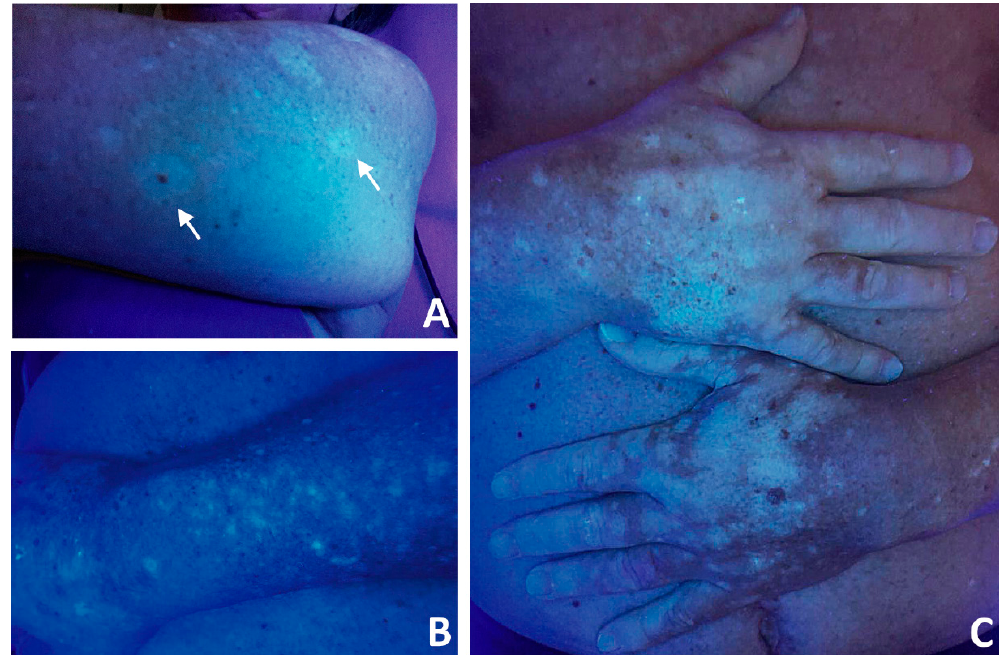
Figure 2. Leukoderma occurring in melanoma patients after treatment with check-point inhibitors. Patients with metastatic melanoma that were treated with check-point inhibitors were enrolled in the study that was approved by the IDI-IRCCS Ethical Committee (510 / 3, 2018). Photographs have been taken through Wood’s lamp examination. Either halo phenomenon around nevi (arrows, ( A )) or broad skin patches ( B , C ) can be observed. Leukoderma images from two representative patients are shown.